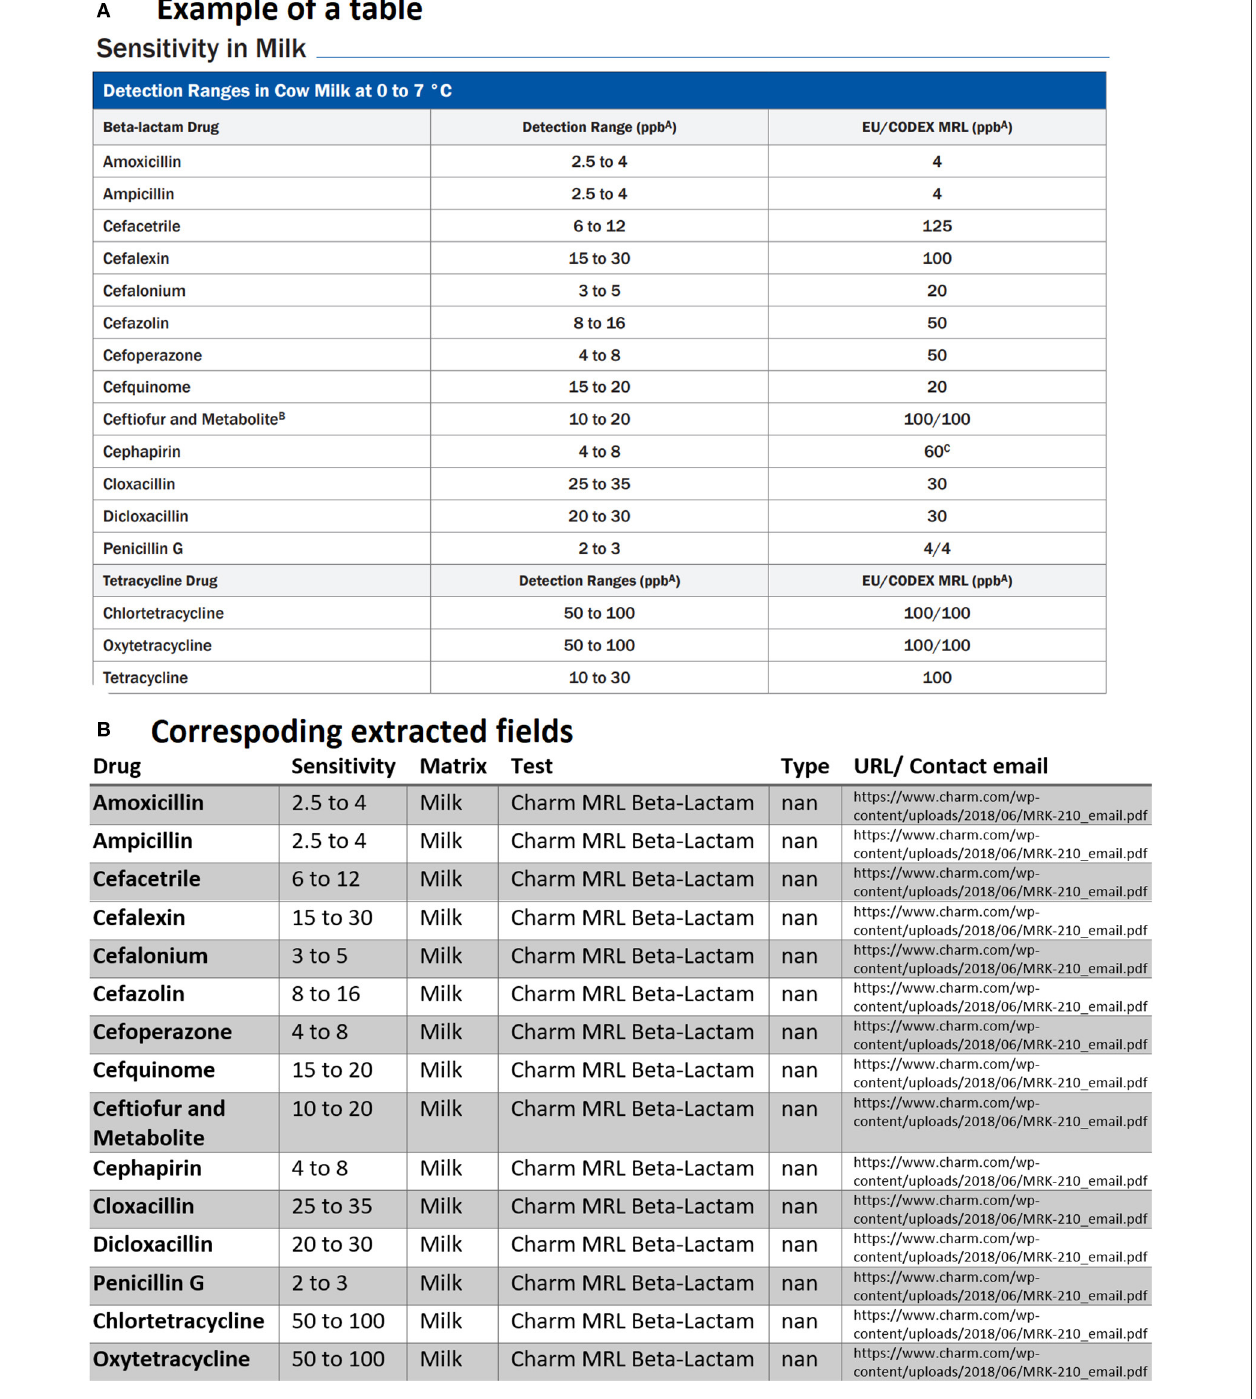
decision making regarding which tests to use, whose results that can then help determine if food products will be safe for human